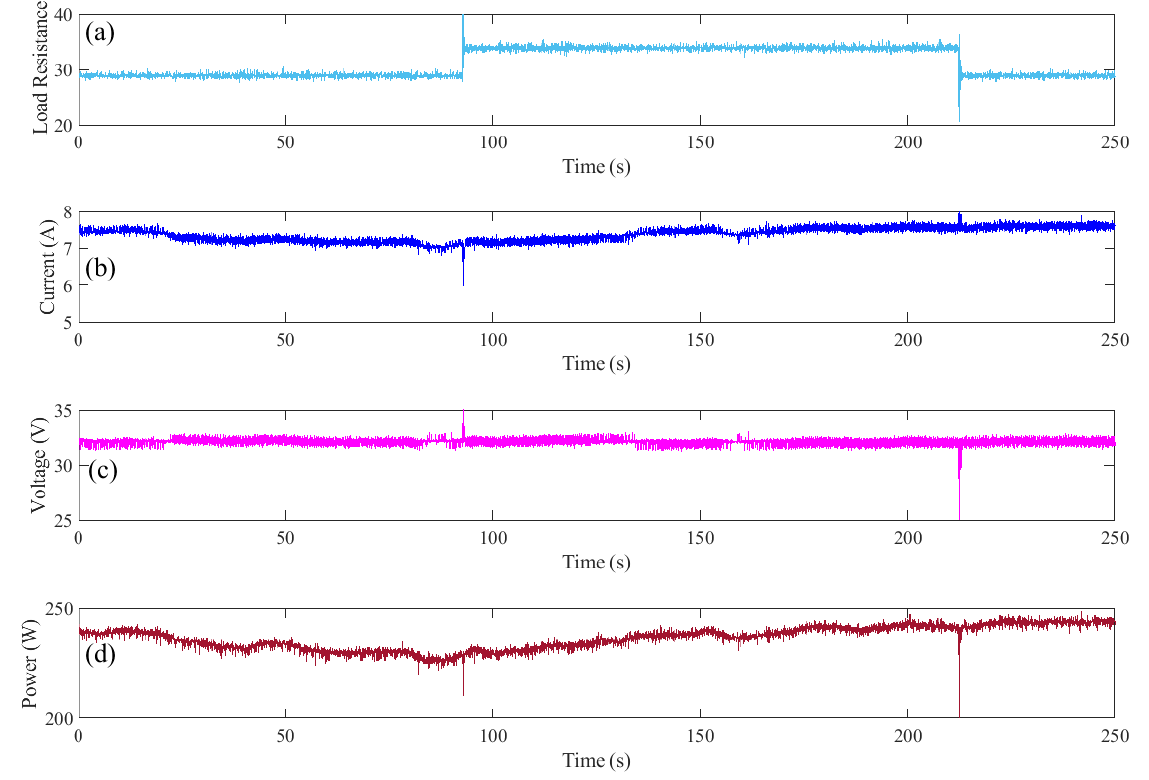
Figure 17. MPPT based on RNN and SMC: ( a ) Load Resistance ( V out / I out ); ( b ) PV current; ( c ) PV voltage; ( d ) PV power.